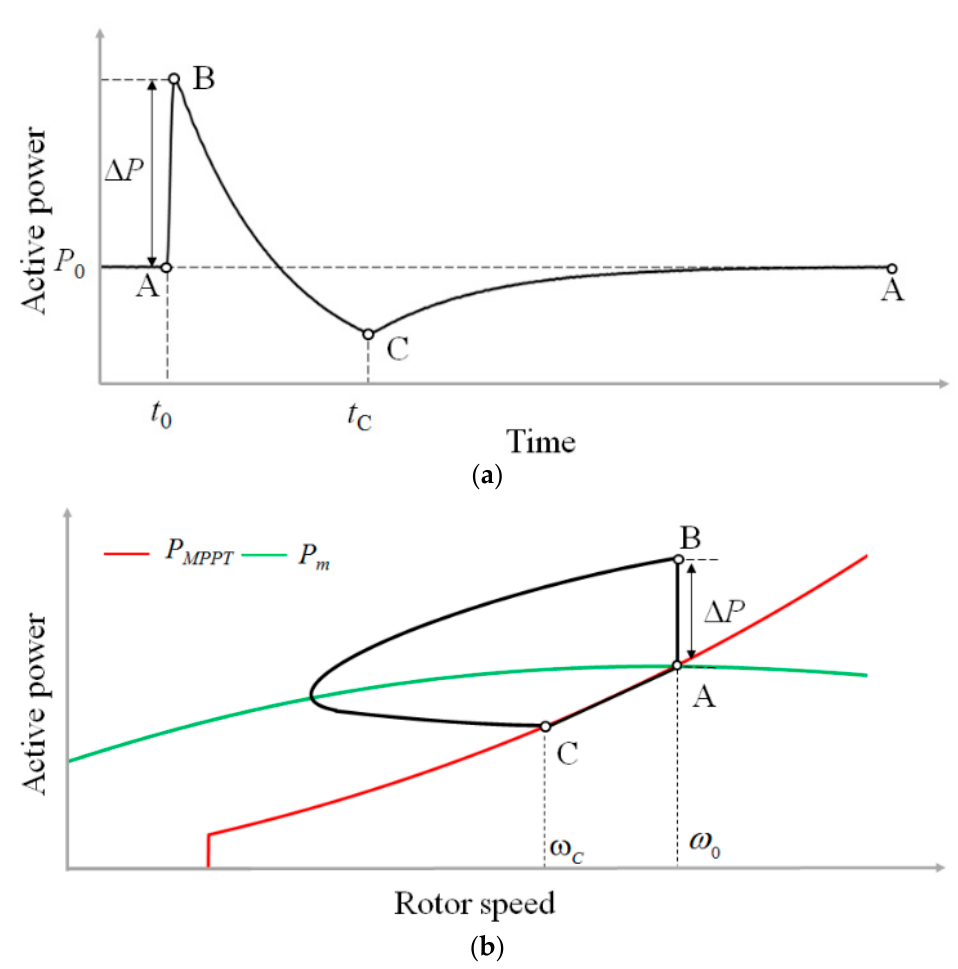
Figure 5. Power reference of SIC #2. ( a ) Power reference in the time domain; ( b ) Power reference in the rotor speed domain.